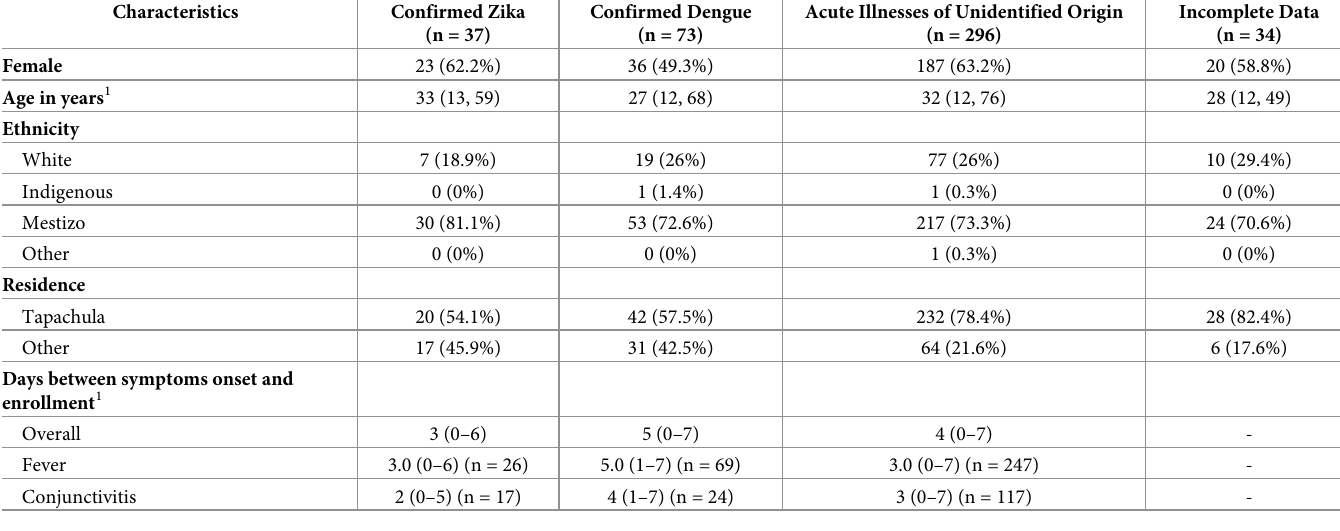
Table 1. Baseline sociodemographic characteristics of 12 years and older patients seeking care within 7 days of onset of symptoms due to acute episodes of fever and/or rash (N = 441). Characteristics